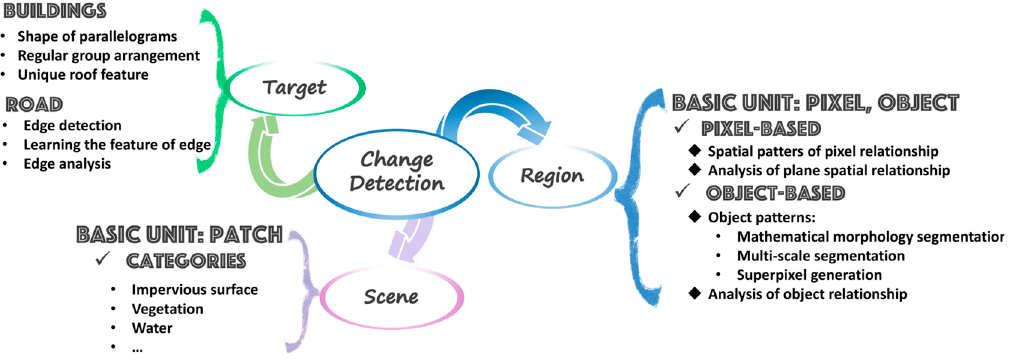
Figure 23. Summary of the multi-objective scenarios.